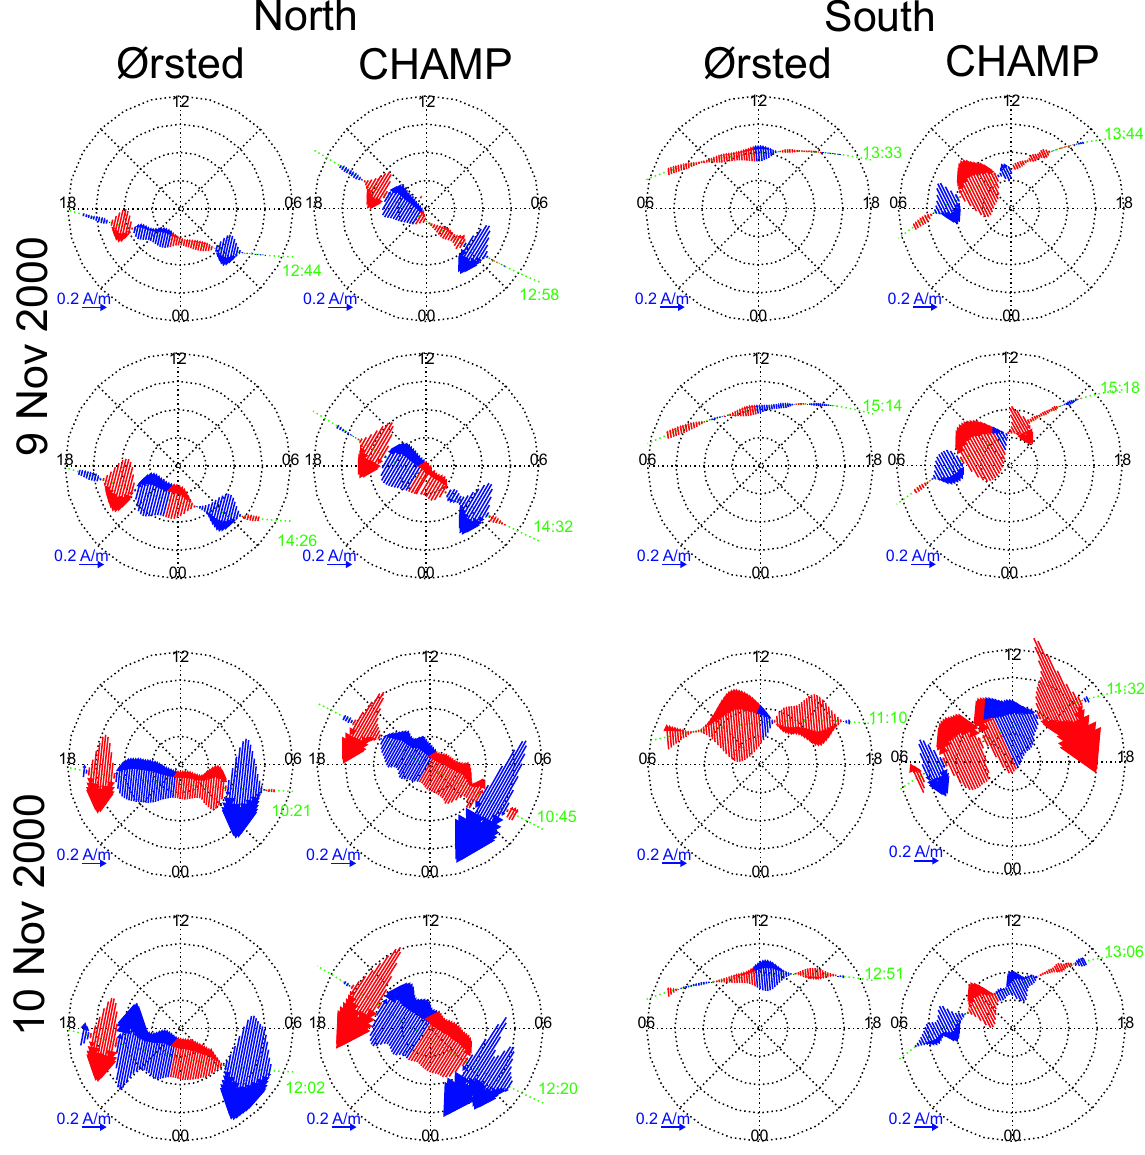
Fig. 4. Shown here are the derived currents for a few selected orbits for which the Ørsted and CHAMP satellites passed the same polar regions nearly simultaneously. The format of the polar maps is the same as in Fig. 1. The Southern Hemisphere maps are viewed as looking down on the south pole from below, i.e. noon is at the top and dusk is to the right. The start time of the passes is marked in green. Each row of maps shows from left to right a Ørsted northern pass, the corresponding (near simultaneous) CHAMP northern pass, the following Ørsted southern pass, and the corresponding CHAMP southern pass. The upper two rows show two successive orbit pairs, and likewise for the lower two rows. It is seen in Fig. 6 that after an initial change from near zero to negative of the Z -component half an hour into the interval, the values of the IMF components are all fairly con- stant throughout the interval. The dominating components are the Y - and Z -components, both of which are negative and at near equal value of roughly − 10 nT. This sets the stage for interpreting the observations presented in Fig. 5. Look- they display a fairly steady and rather low intensity